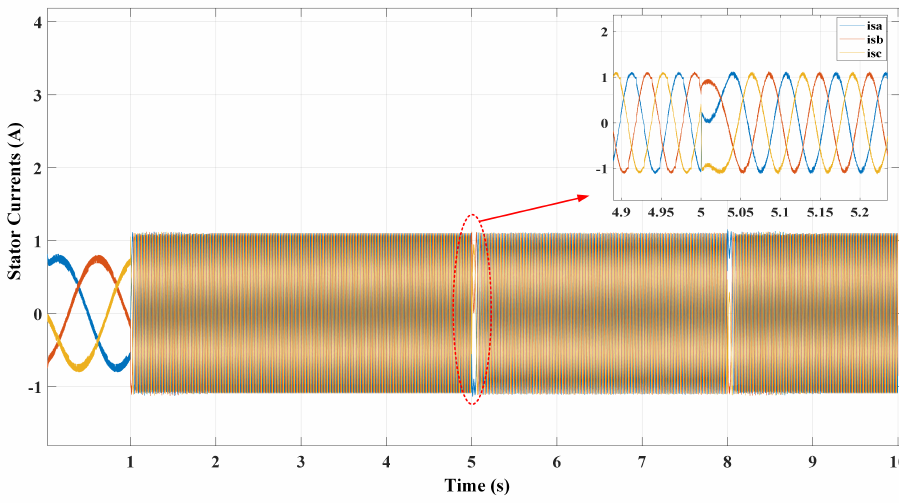
Figure 10. Responses of the three-phase stator currents in the proposed